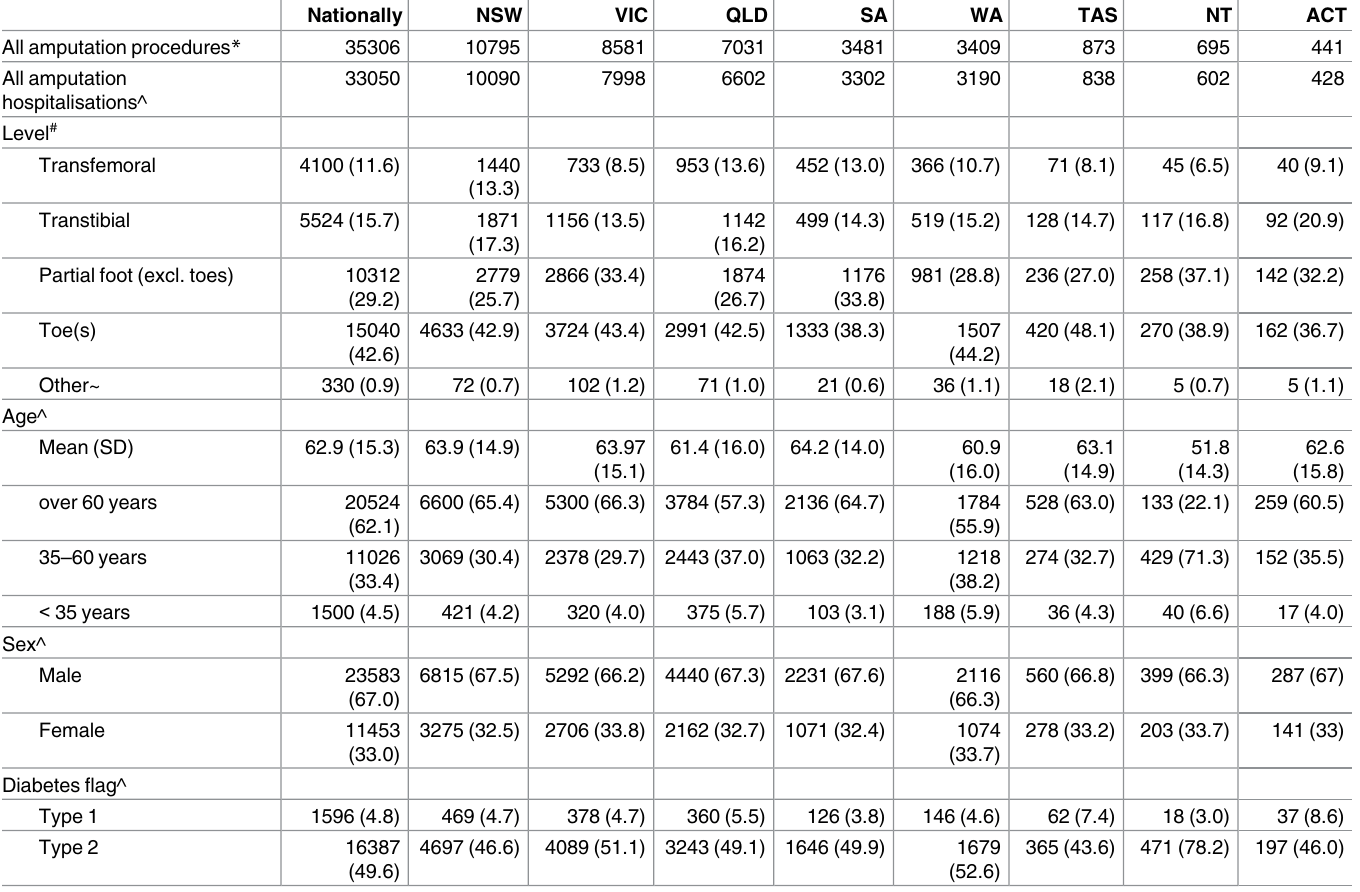
Table 1. Demographic characteristics by state/territory for all yearscombined (from 2007–8to